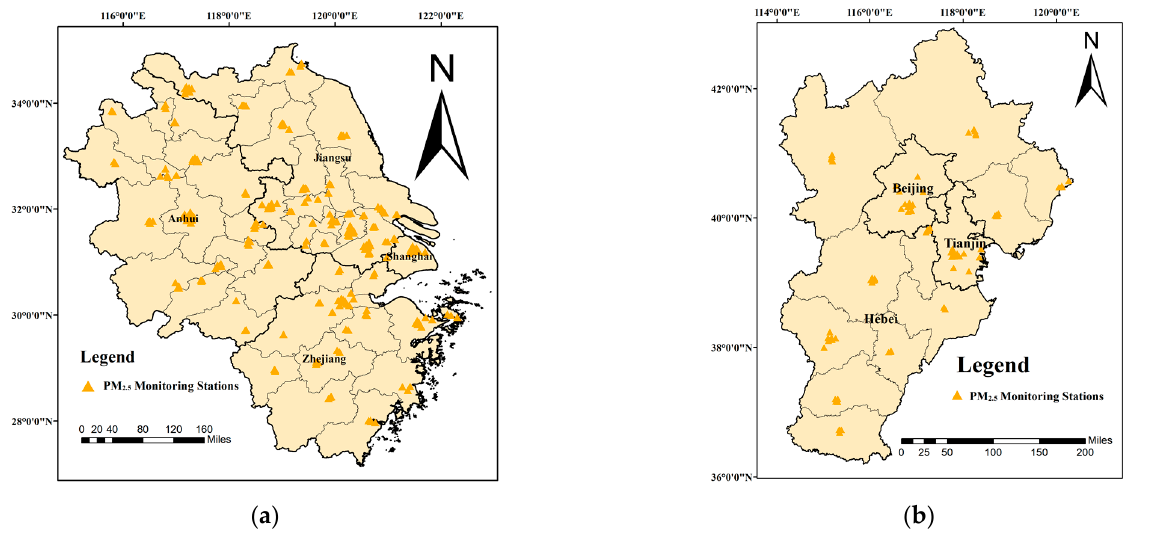
Figure 1. The YRD region ( a ) and the BTH region ( b ).